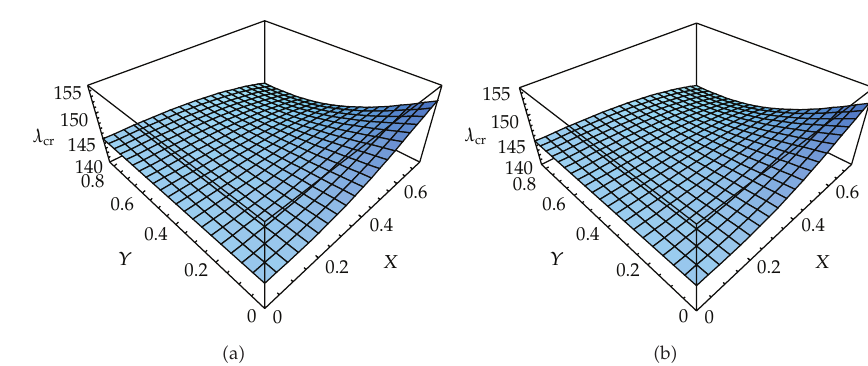
Figure 3: Variations of critical dynamic pressure versus patch location: (cid:3) a (cid:6) with reduced mass and (cid:3) b (cid:6) with reduced sti ff ness.